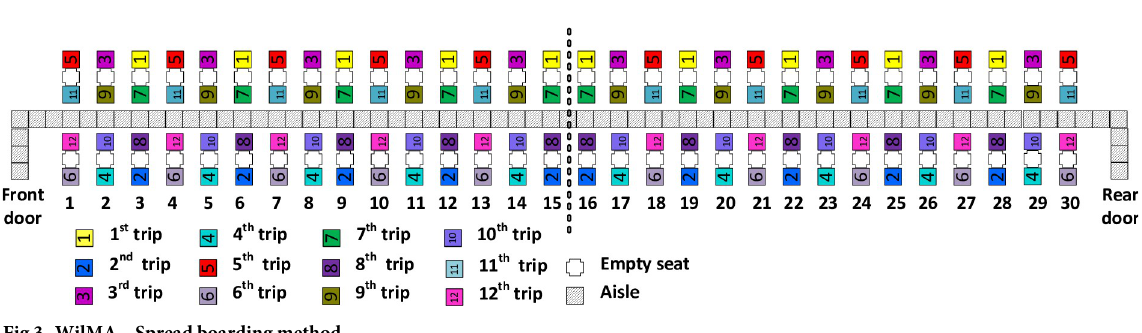
Fig 3. WilMA—Spread boarding method.